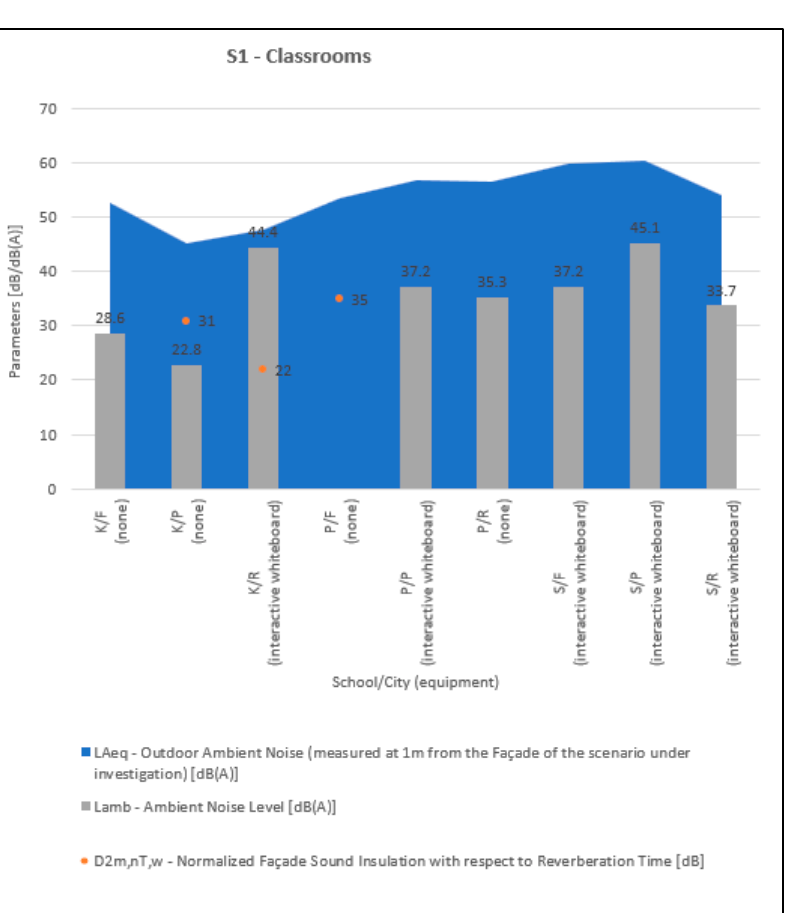
Figure 2. Acoustic measurement results of the nine classrooms (outdoor ambient noise measured at 1 m from the facade, ambient noise level, and normalised facade sound insulation with respect to reverberation time) regarding noise produced by sources placed outside the building.